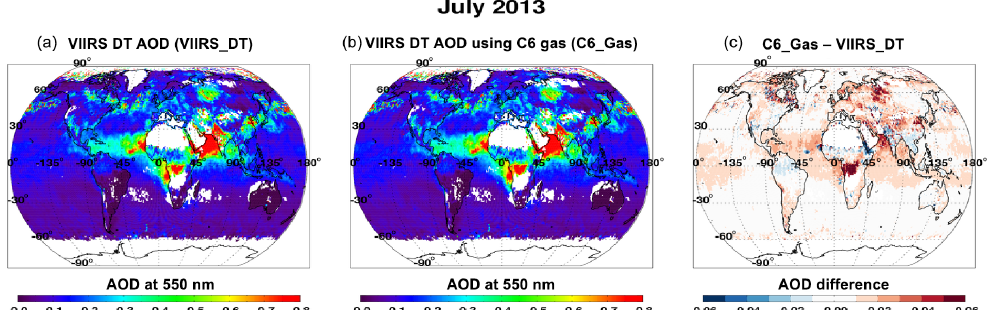
Figure 7. Impact of updated atmospheric corrections on VIIRS AOD (550nm) retrieval. All things being equal, using the C6 aerosol DT retrieval algorithm (a) is AOD using atmospheric coefficients calculated for VIIRS bands, and (b) is AOD using C6 atmospheric corrections; (c) is the difference between (b) and (a) . The global mean AOD differs by ∼ 0.012 over land and by ∼ 0.004 over ocean. Difference are larger than these mean values regionally but <0.08. Differences are mostly positive (reds) except in some desert/bright regions where some negative differences